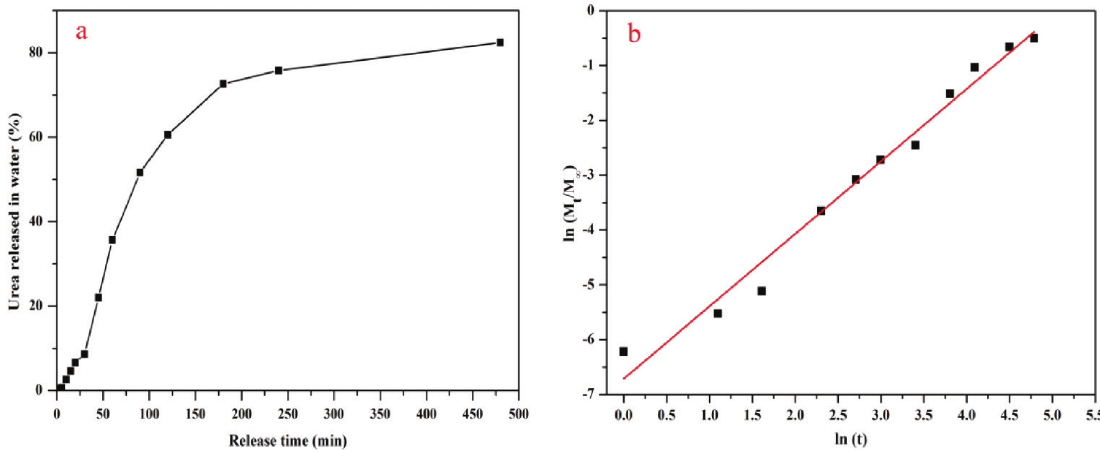
Figure 11: The release behavior (a) and release kinetic (b) of SC-g-PAA/PAM/Urea in water.